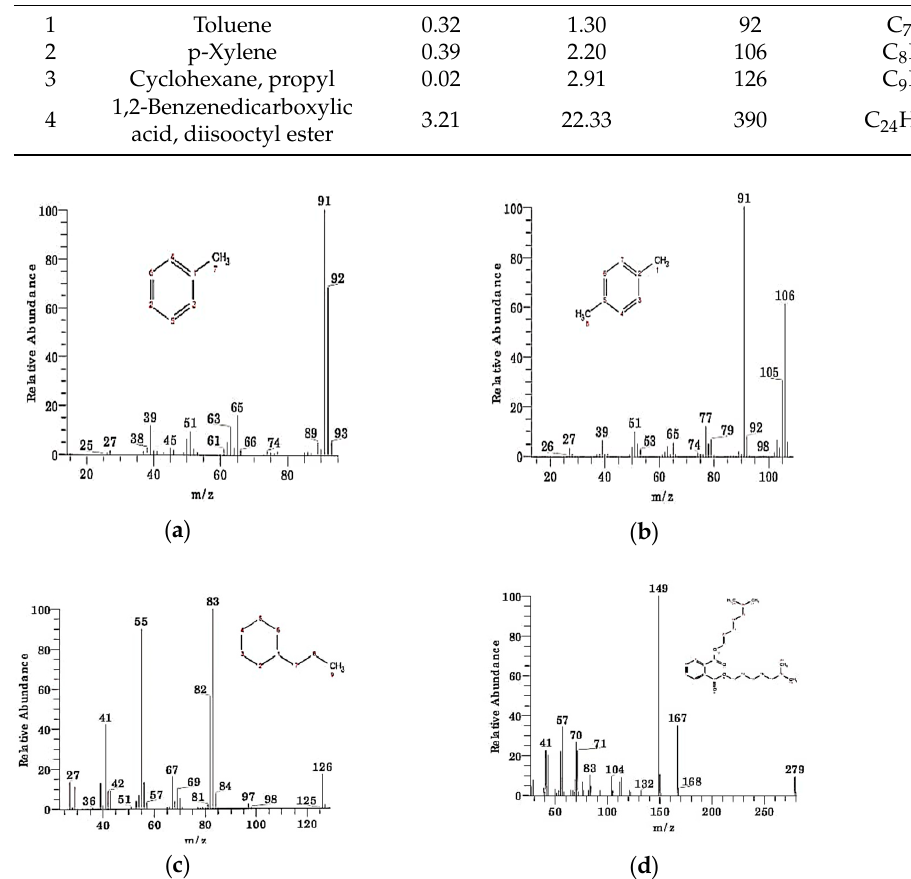
Table 1. GC-MS analysis and Identified compounds from degraded mixture.